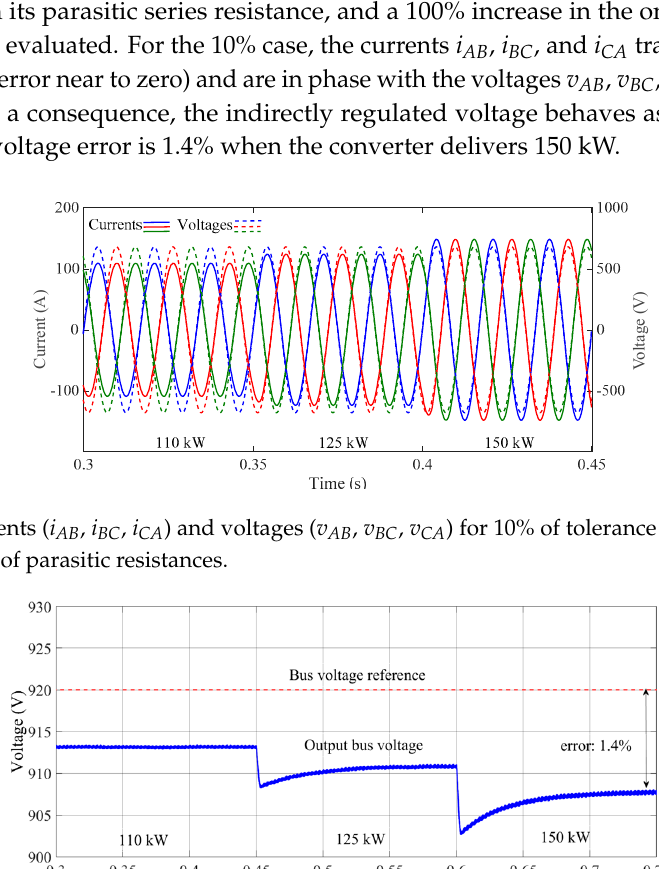
Figure 14. Output voltage V DC during a grid voltage variation ( ± 10%).